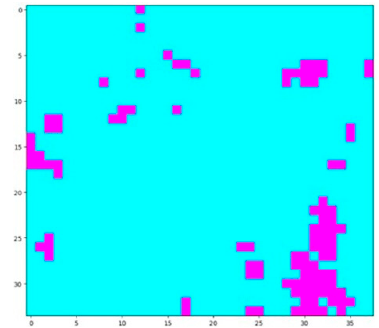
Figure 10. Original ROI rasterization. The labeled ROI occupied 106 grids in total in the research region (38 × 34 grids). The purple grids indicate the labelled regions.